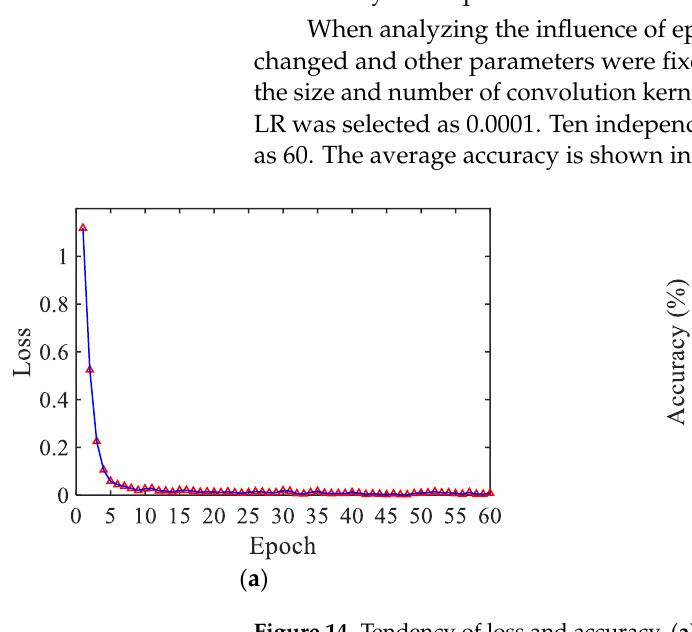
Figure 13. The average accuracy with different LRs.